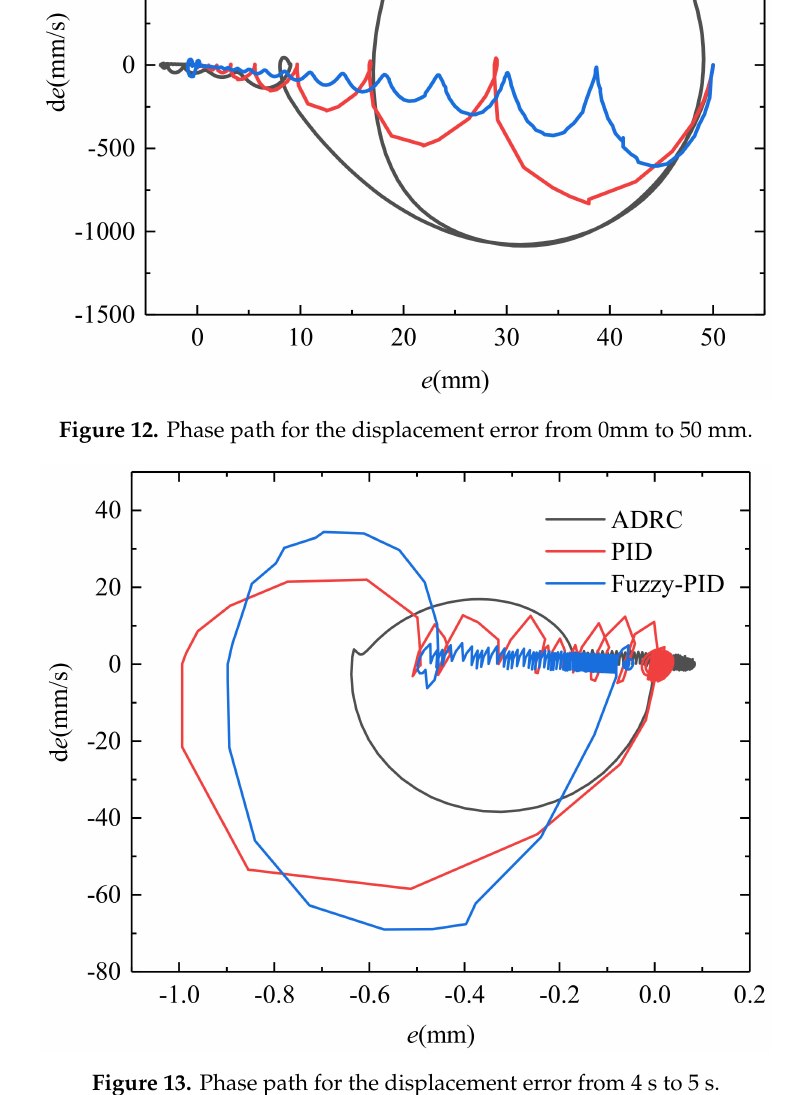
Figure 13. Phase path for the displacement error from 4 s to 5